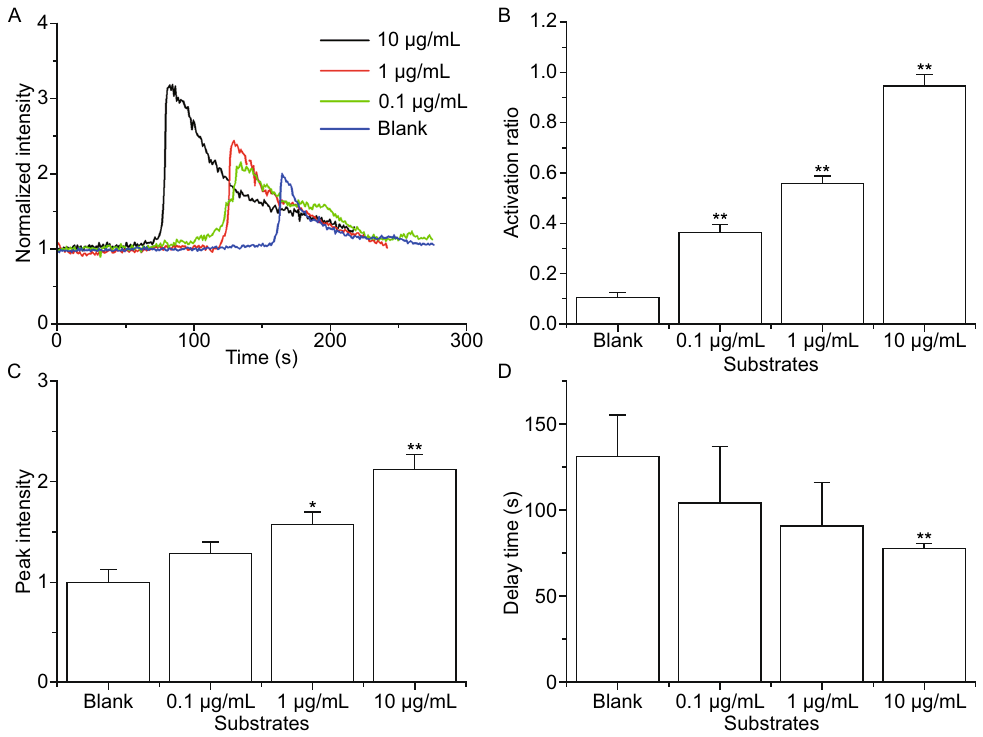
Figure 3. Variation of activation ratio, peak intensity, and delay time for calcium signaling of fi rmly adhered neutrophils in fl ow versus P-selectin concentration. (A) The time-course, (B) the activation ratio, (C) the peak intensity and (D) the delay time of calcium signaling with various P-selectin concentrations (0.0, 0.1, 1.0, and 10 μ g/mL) at a wall shear stress of 0.2 Pa. The data represent the mean ± SEM from at least 20 cells in 3 independent experiments. The signi fi cant level of difference from the untreated substrate group is shown by P -value, * for P < 0.05 and ** for P <